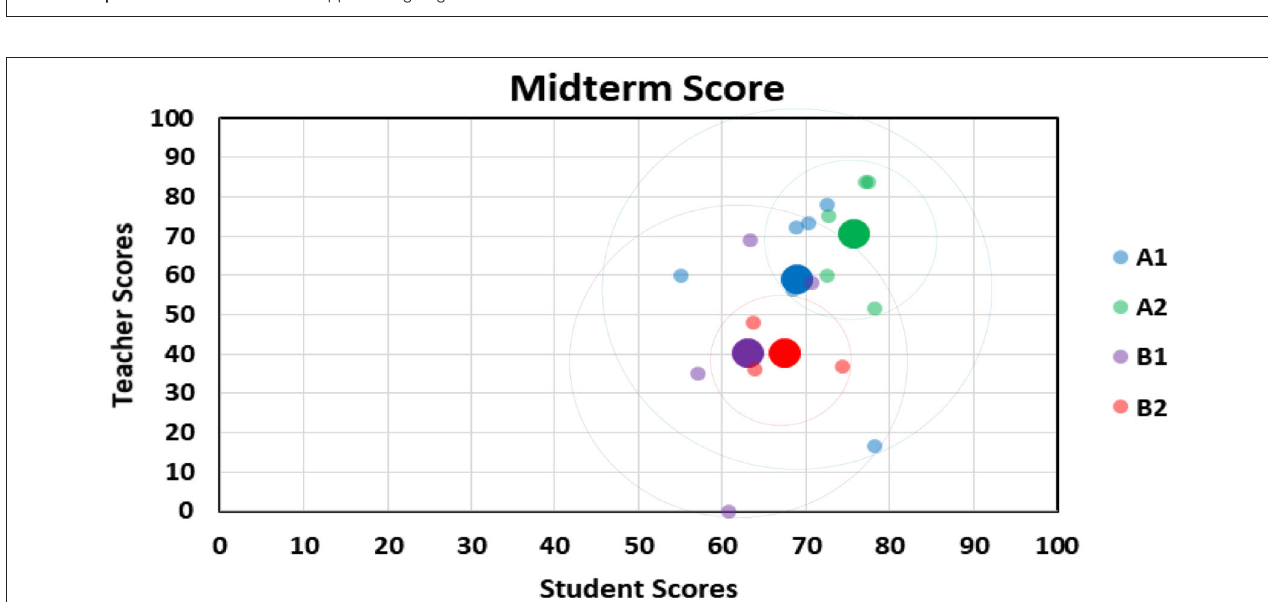
FIGURE 2 | Teacher and student score approaching degree.